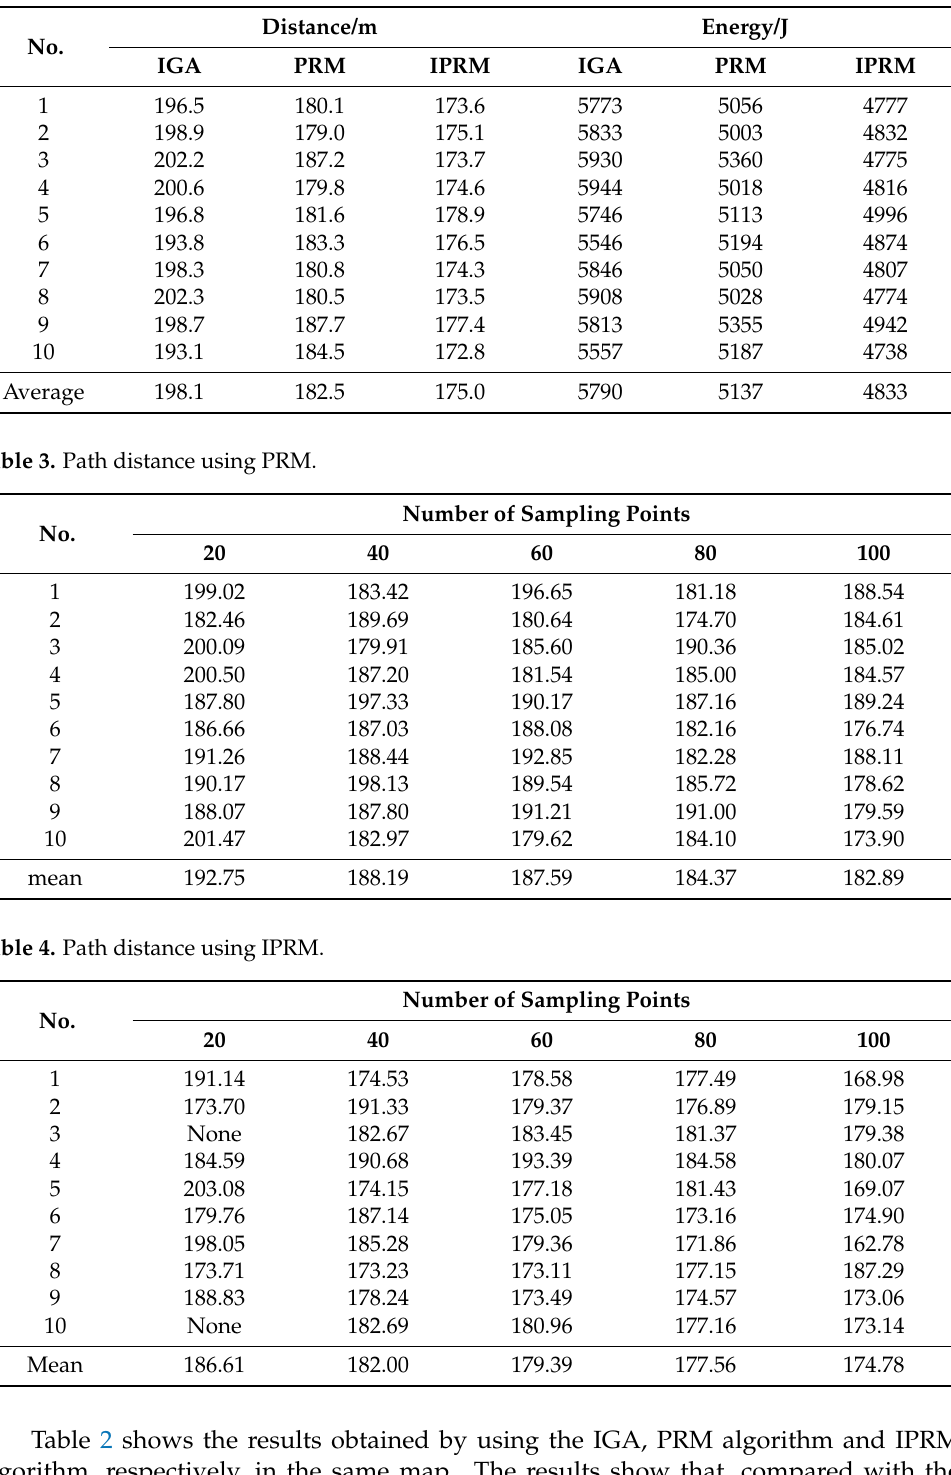
Table 2. The experimental results using different algorithms.